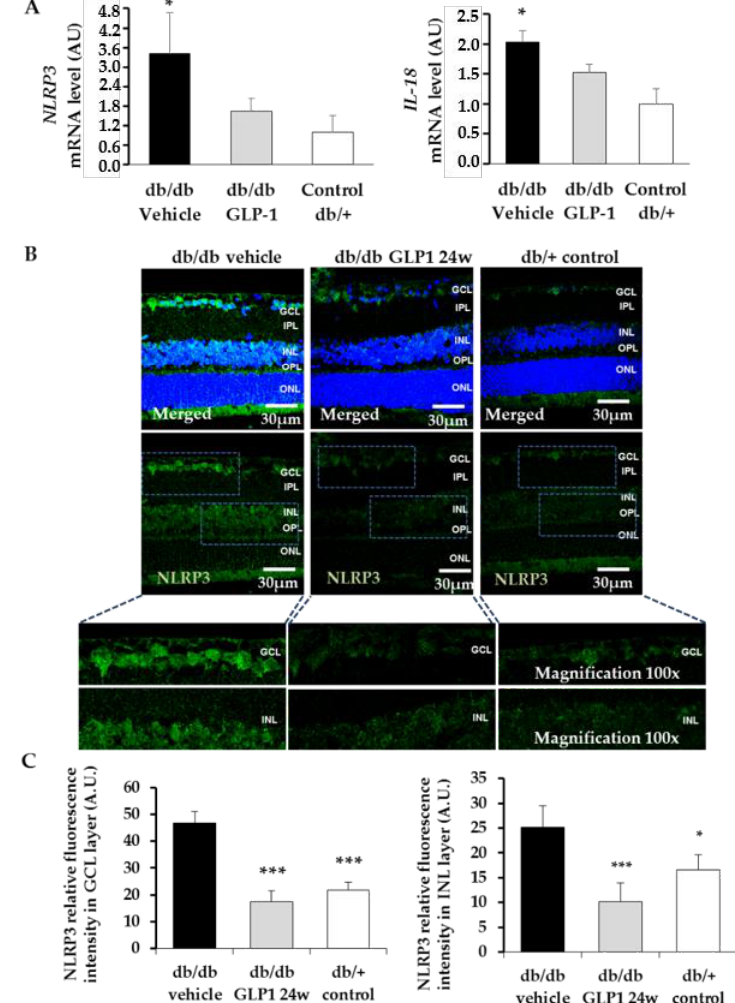
Figure 7. ( A ) Real-time quantitative reverse transcription polymerase chain reaction (RT-PCR) analysis of NLRP3 and IL-18 in db/db mice treated with vehicle (black bars), db/db mice treated with glucagon-like peptide-1 (GLP-1) eye drops (grey bars) and non-diabetic mice (white bars) n = 4 * p < 0.05 db/db vehicle in comparison with other groups; ( B ) Comparison of NLRP3 immunoreactivity (red) among representative samples from diabetic mice treated with vehicle or GLP-1 eye-drops and from a non-diabetic mouse and quantification of the immunofluorescence ( C ). Nuclei were labelled with Hoechst stain (blue). Scale bars, 30 µ m; n = 4 * p < 0.05 in comparison with db/db GLP-1; *** p < 0.001 in comparison with db/db vehicle. GCL, ganglion cell layer; INL, inner nuclear layer; IPL, inner plexiform layer; ONL, outer nuclear layer; OPL, outer plexiform